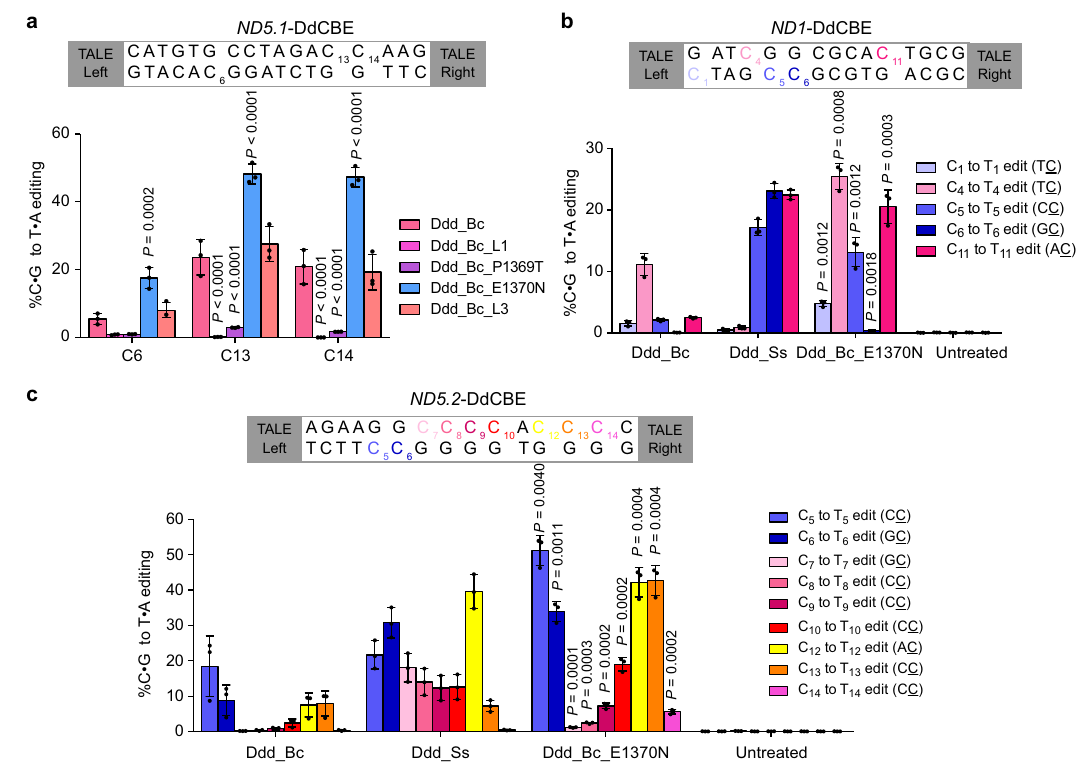
Fig. 5 | E1370N mutation extensively increases the editing ef fi ciency and sequence compatibility of DdCBE_Bc. a mtDNA editing ef fi ciencies of HEK293T cells treated with ND5.1 -DdCBE derived from different Ddd_Bc variants. For Ddd_Bc_L1 and Ddd_Bc_L3, loop 1 and loop 3 sequences in Ddd_Bc are replacedwiththe corresponding sequence of Ddd_Ss as shown in Supplementary Fig. 11a. Shown are mean±SD; n =3 independent experiments. P values were